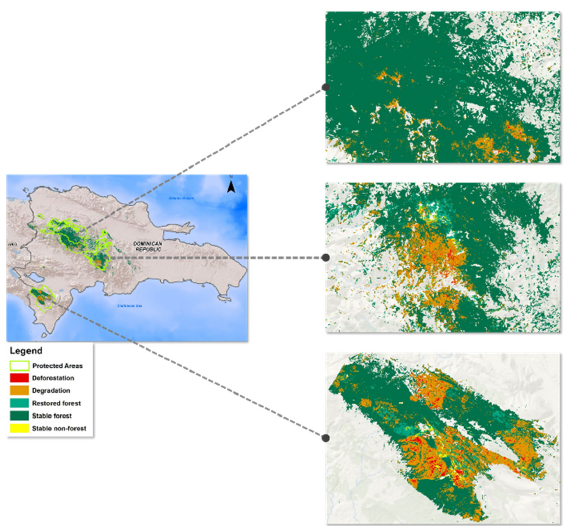
Figure 9. Dynamic land cover change map for the 1990–2018 period.